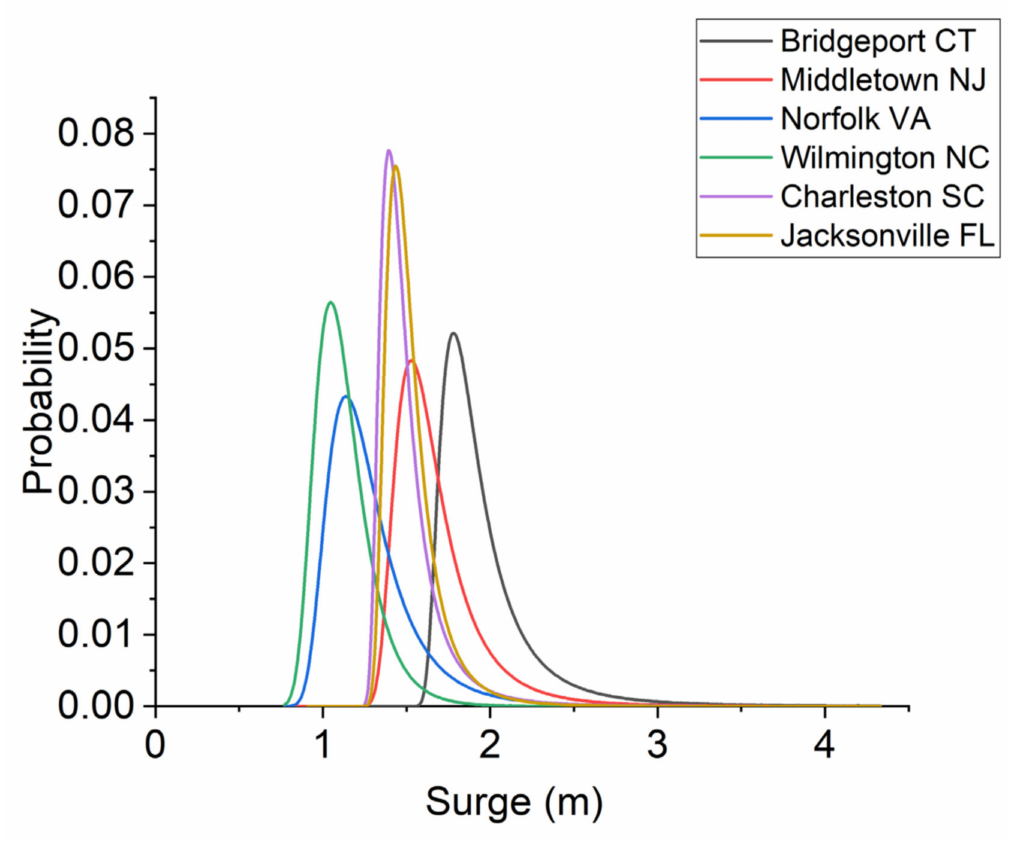
Figure 1. Probability distribution of storm surge by site. Source: Author estimation using data from [7] and a Generalized Extreme Value